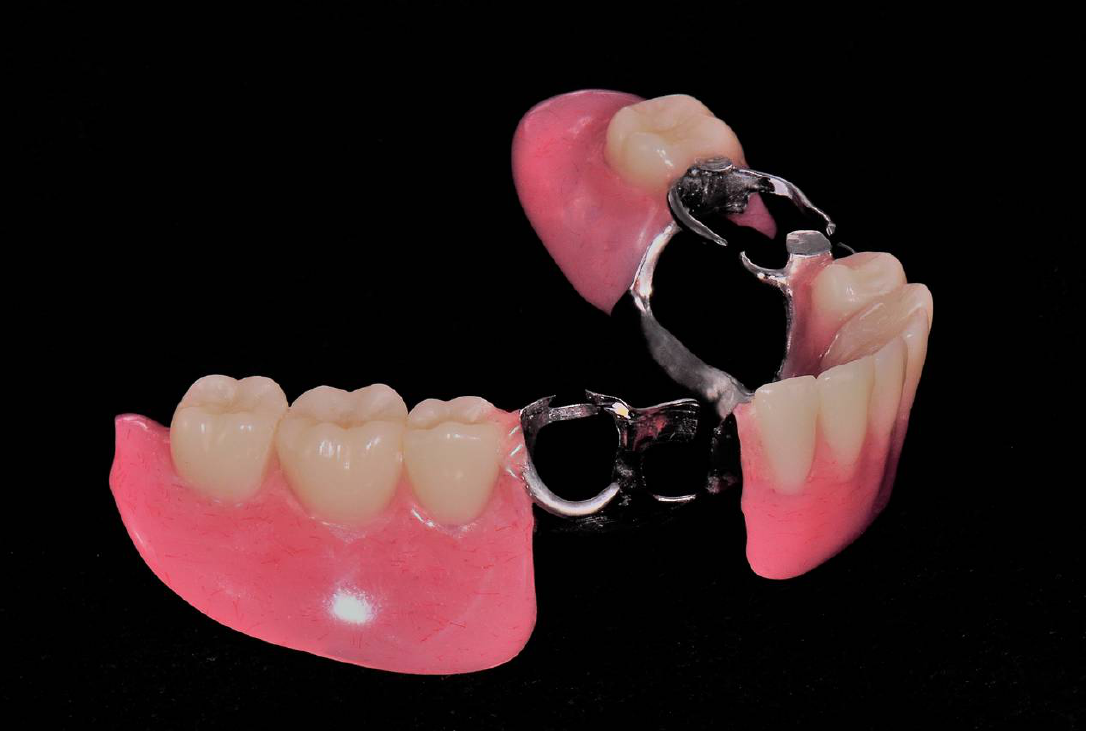
Figure 6. Completed removable partial denture.